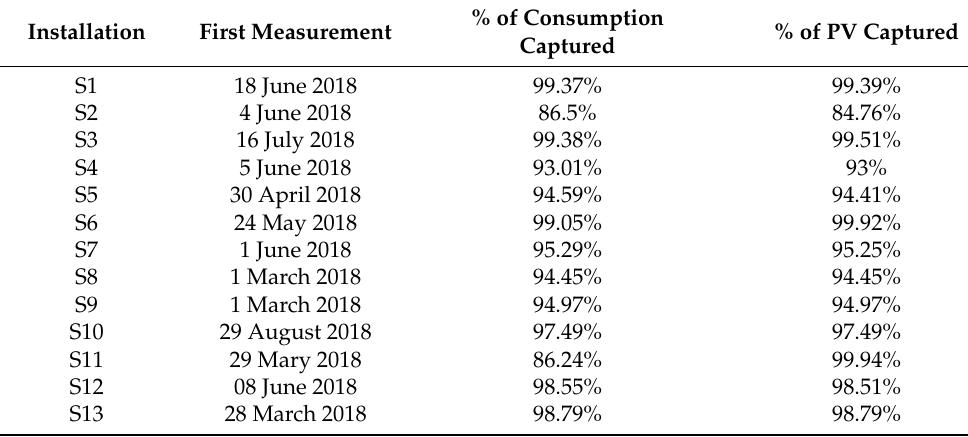
Table 2. Summary of the captured data for the 13 sites part of the case